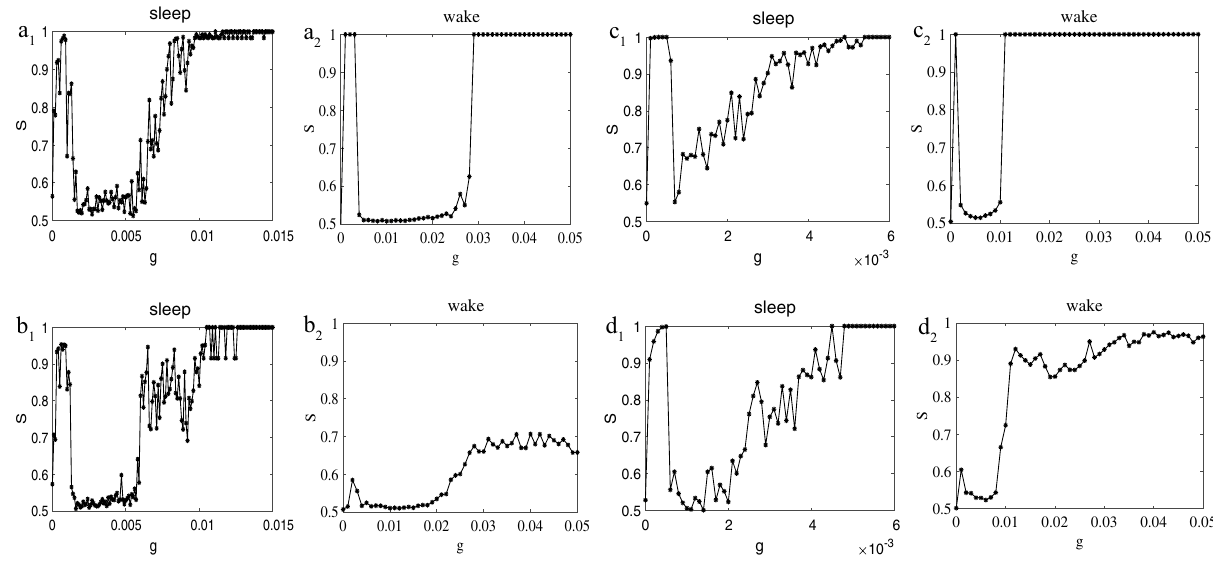
Figure 7. Synchronization comparison diagrams for the WS network ( p = 0.1) and ring-shaped regular network during sleep and wake. ( a ) and ( c ) S − g curves for the WS network with k = 4, p = 0.1 and k = 10, p = 0.1 . ( b ) and ( d ) ring-shaped regular network with k = 4, p = 0 and k = 10, p = 0